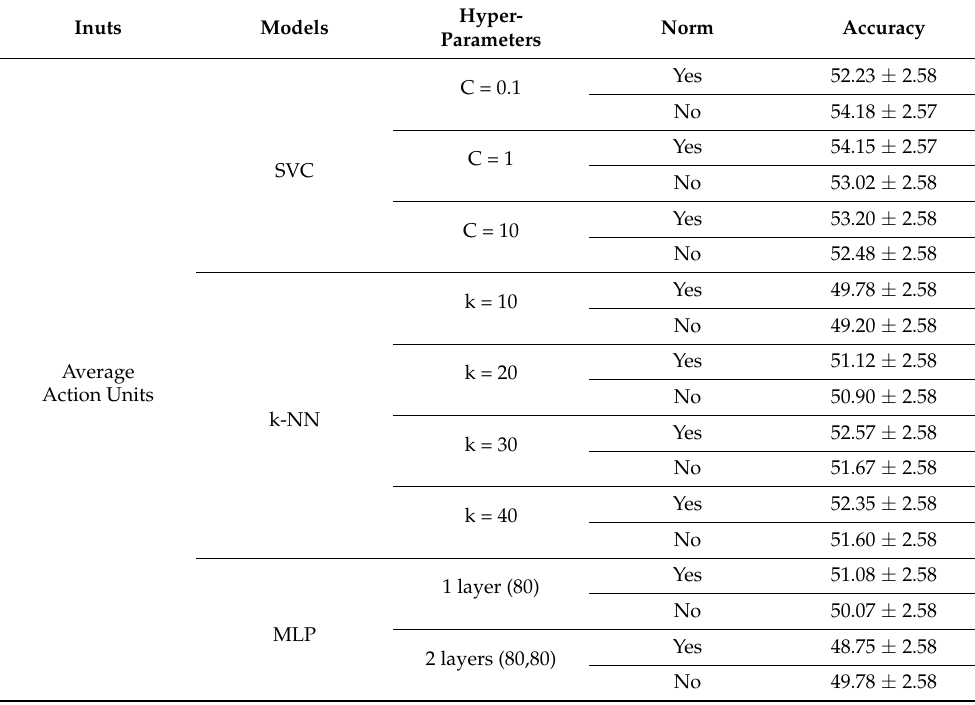
Table A2. Quantitative evaluation of the strategies applied for the FER using all the frames as training. Results reported at video level after applying max.